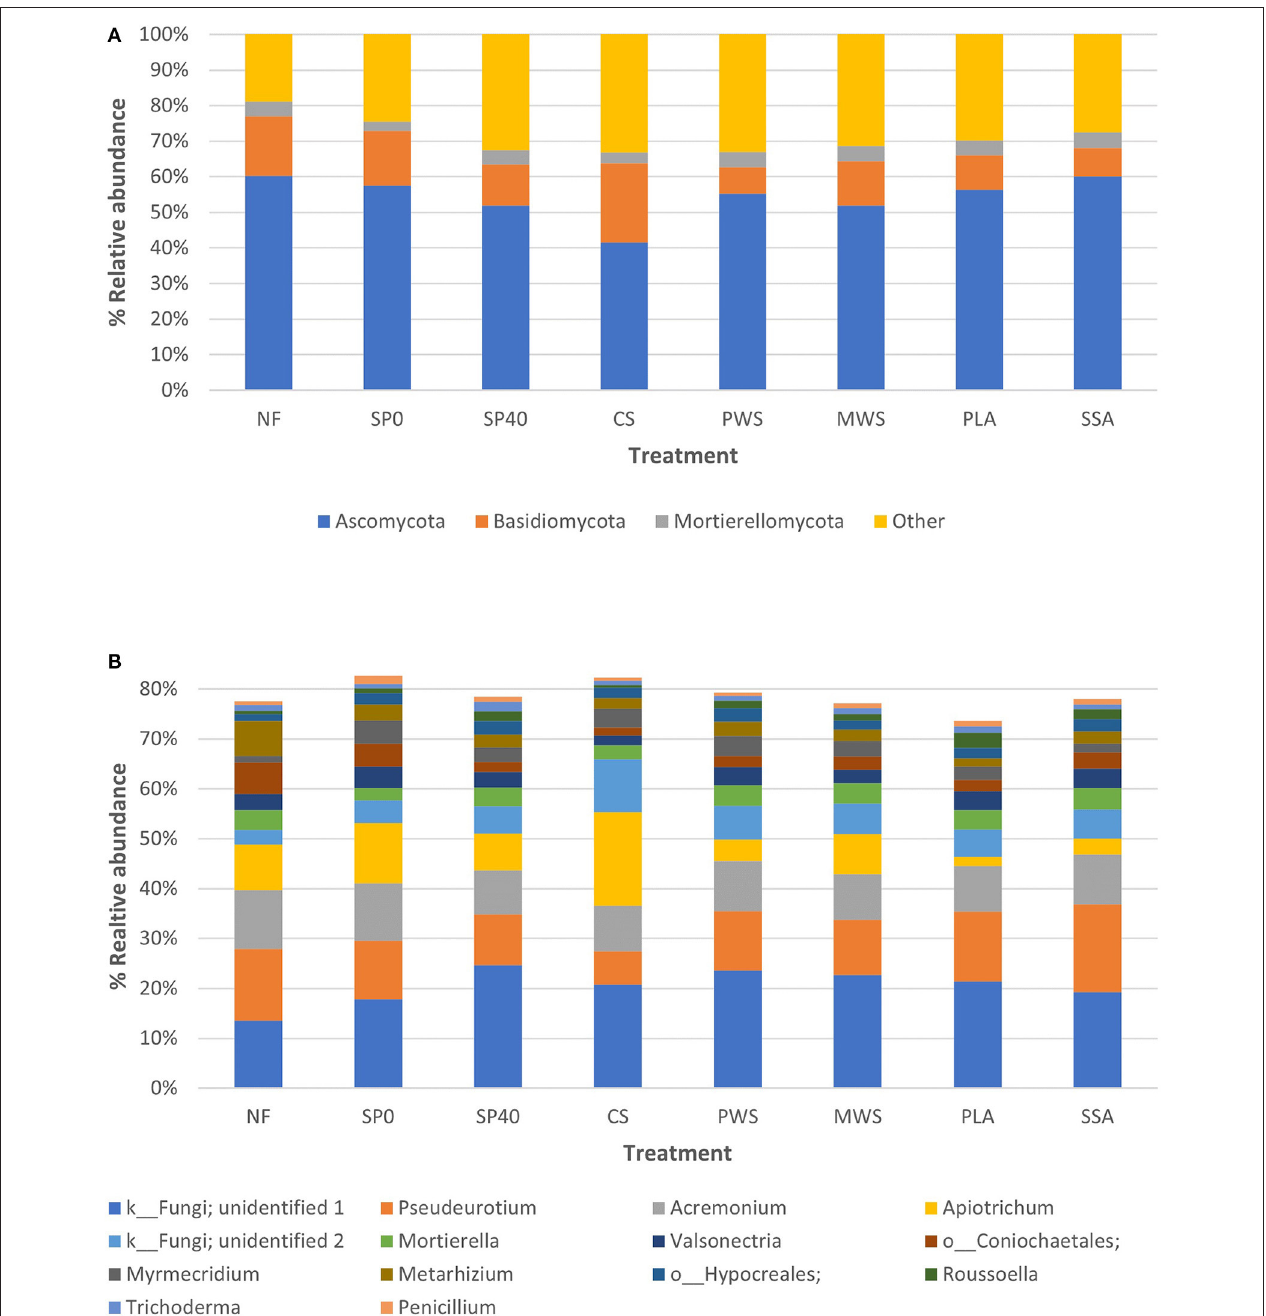
FIGURE 2 | The average relative abundances of (A) the top three fungal phyla and (B) the top 10 fungal genera, observed in each of the treatment groups ( n = 5). Treatment group name: NF, No fertilizer; SP0, No phosphate; SP40, mineral super phosphate; CS, cattle slurry; PWS, potato waste struvite; MWS, municipal waste struvite; PLA, poultry litter ash; SSA, sewage sludge